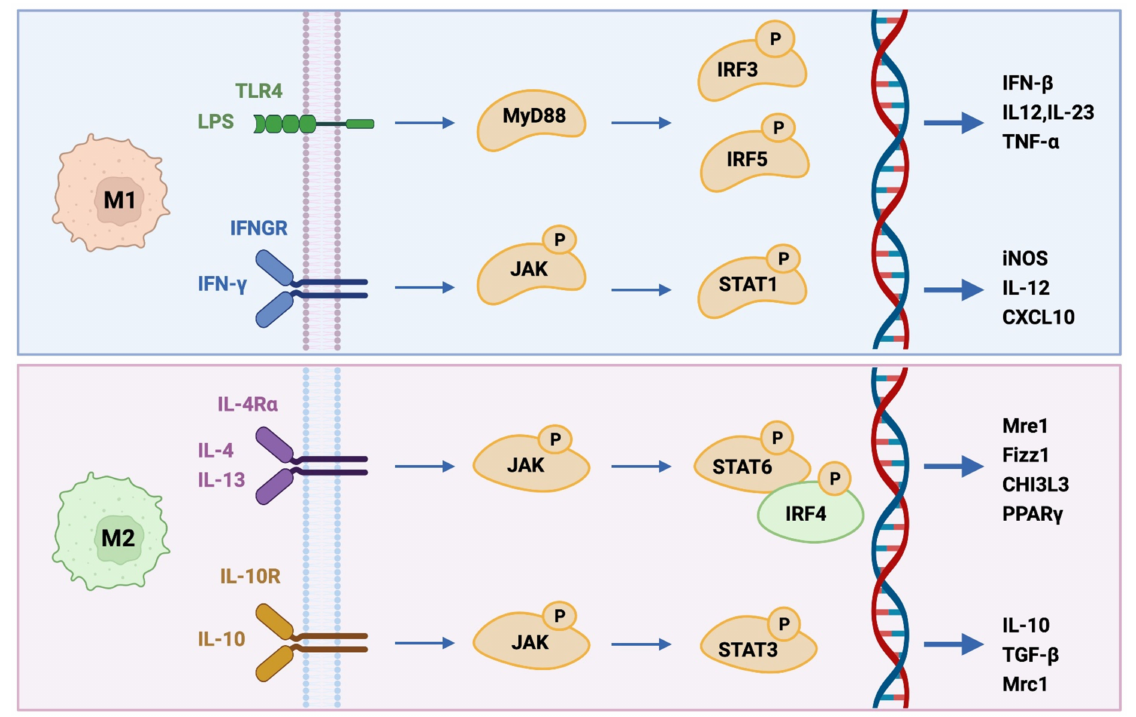
Figure 1. Major M1 and M2 differentiation pathways. Briefly, M1-like macrophages (upper panel) can be induced by IFN- γ and LPS-mediated activation of TLR-4 signaling pathway, promoting inflammatory responses by secreting cytokines such as TNF- α , IL-1 α , IL-1 β , IL-6, IL-12, IL-18, and IL-23. Alternatively, IL-4 and IL-13 induce macrophages to M2-like (lower panel) by activating STAT6 via the IL-4 receptor alpha (IL-4R α ), whereas IL-10 promotes M2 phenotype by activating STAT3 through IL-10R. In the IL-4 and IL-13 pathway, receptor binding of IL-4 activates JAK1 and JAK3 leading to STAT6 activation and